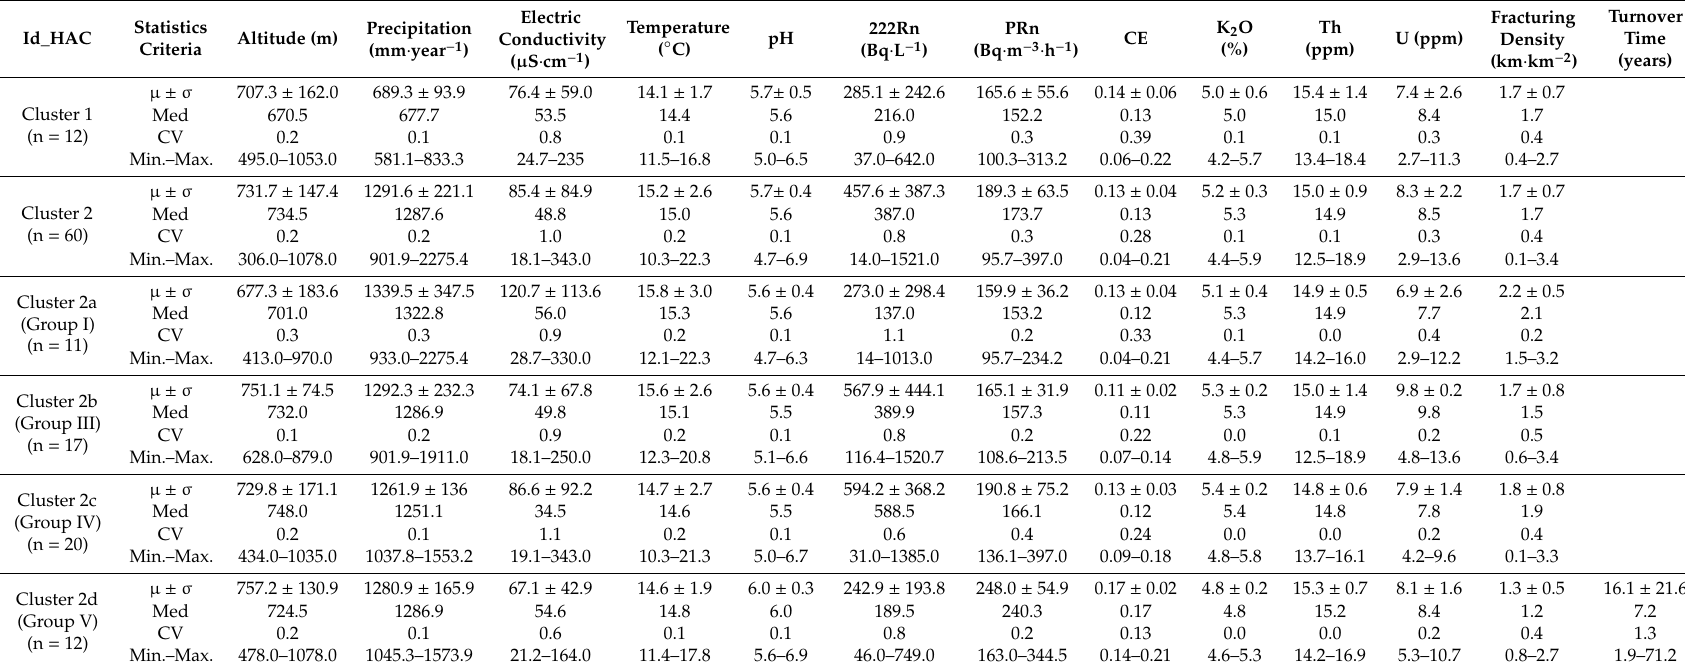
Table 4. Descriptive statistics for climatic, topographic, physical-chemical water properties, and geogenic parameters of each cluster used for PLS-PM, including the segmentation performed on the C2 cluster based on the granite